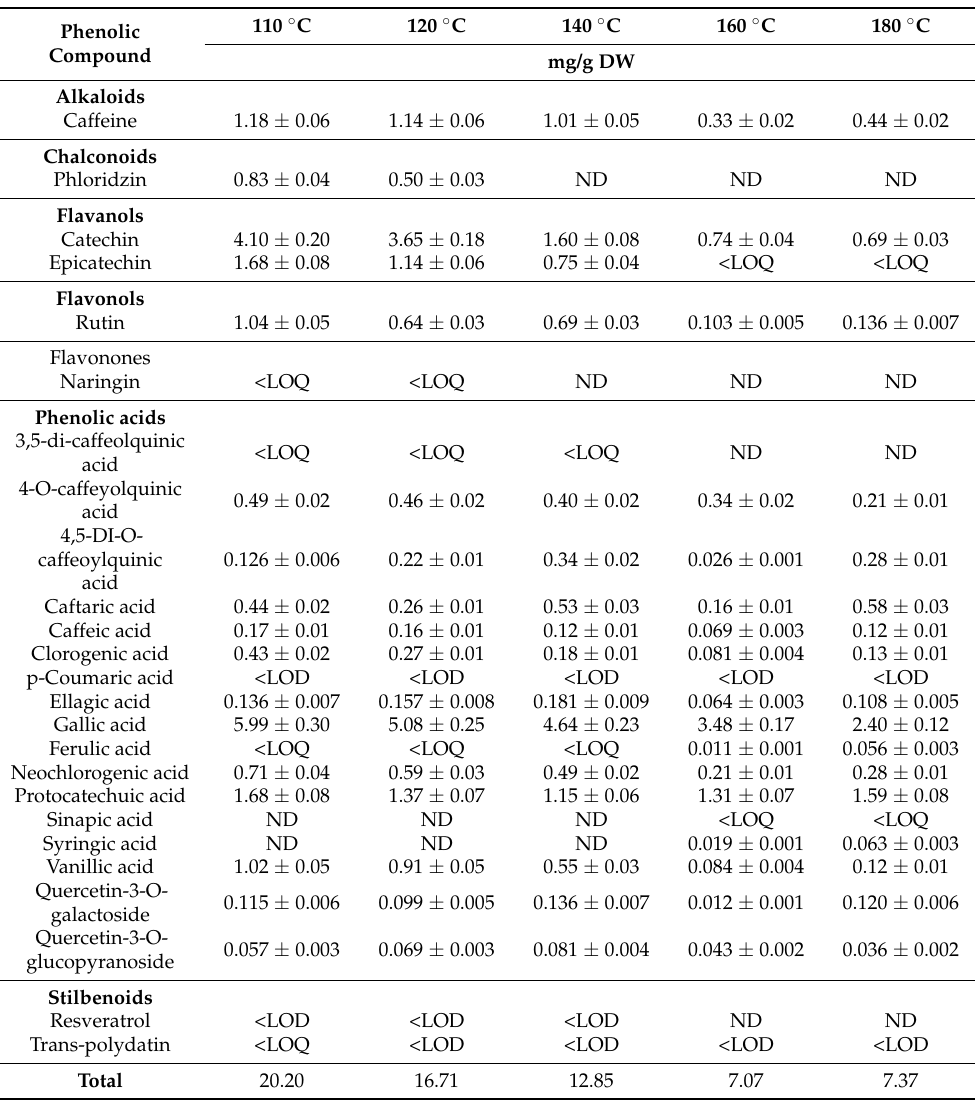
Table 2. Identification and quantification (mg/g DW) of phenolic compounds present in C. sativa shells SWE extracts by HPLC-PDA analysis. Results are expressed as mean ± standard deviation ( n =